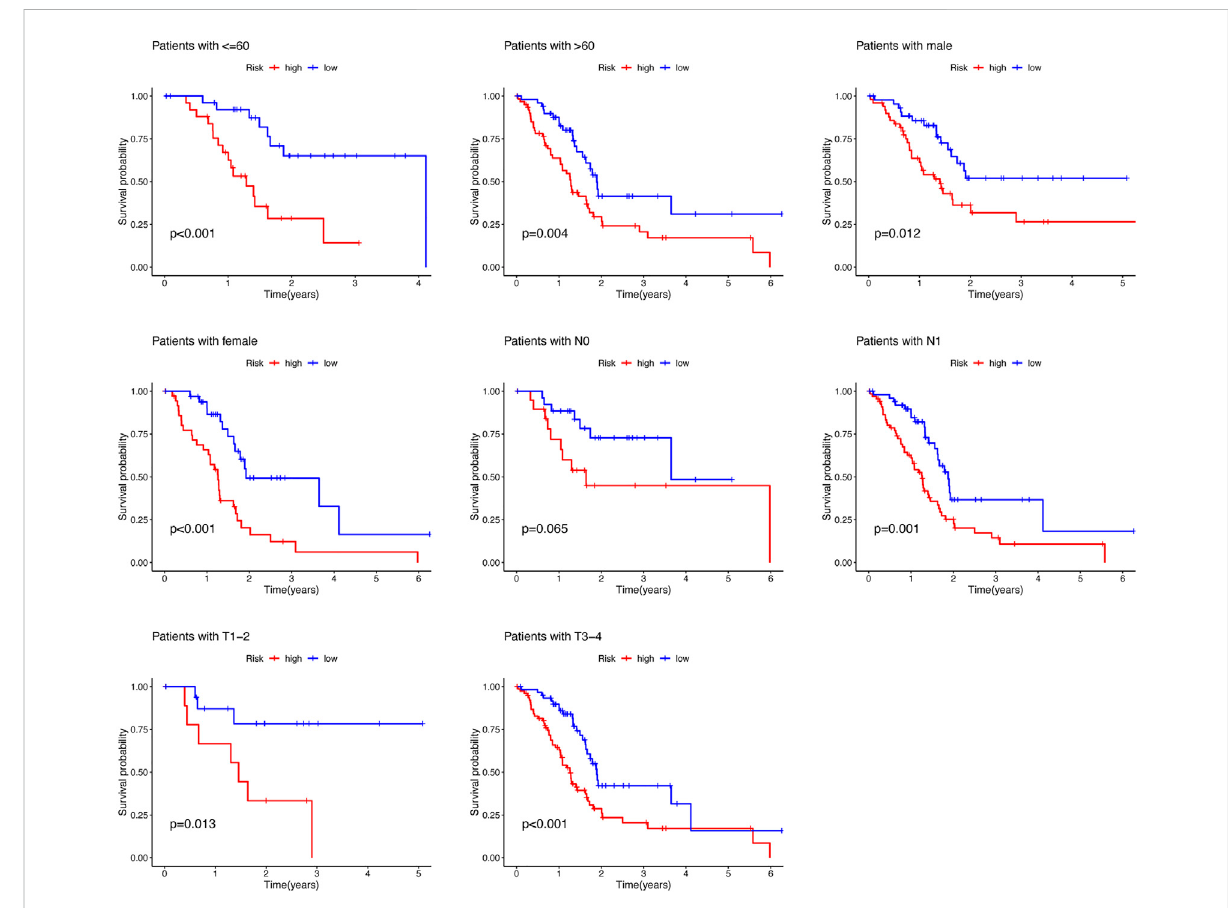
FIGURE 3 Survival rate of PAAD patients with high- and low-risk patients in the subgroups based on clinicopathological